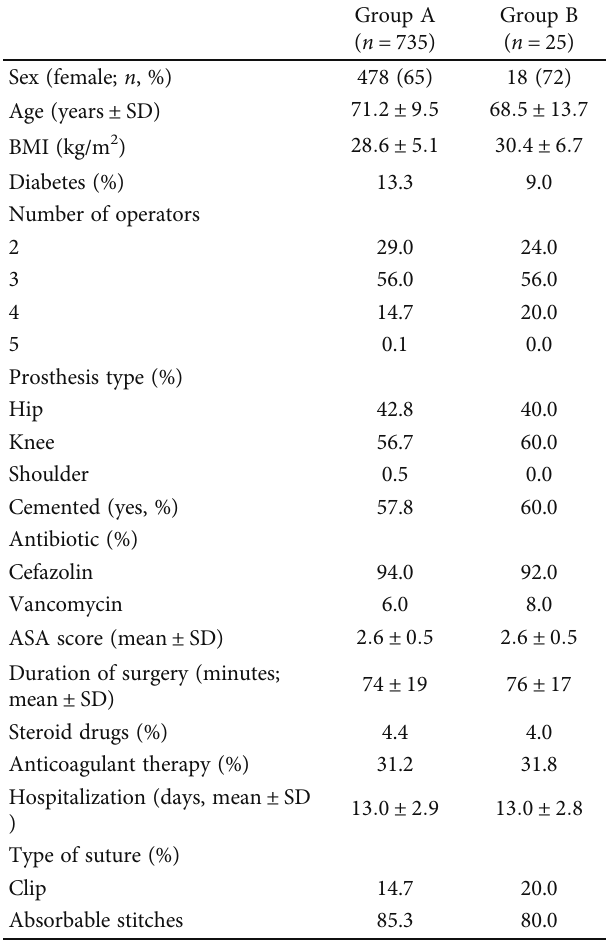
Table 1: Demographics and clinical variables for controls and